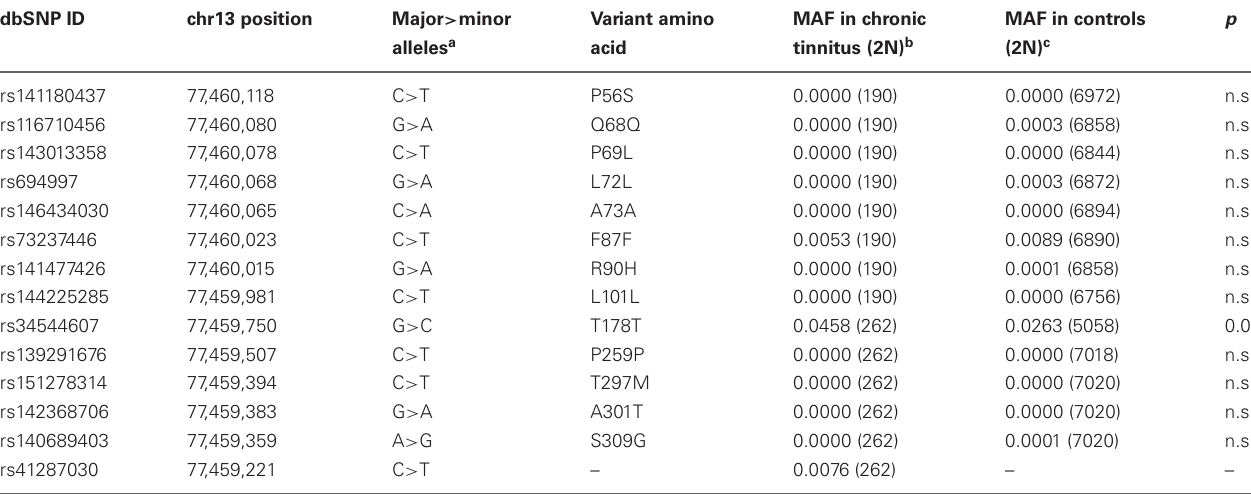
Table 1 | Allele frequencies for the KCTD12 sequence screened in subjects with chronic tinnitus as compared to frequencies in a large control